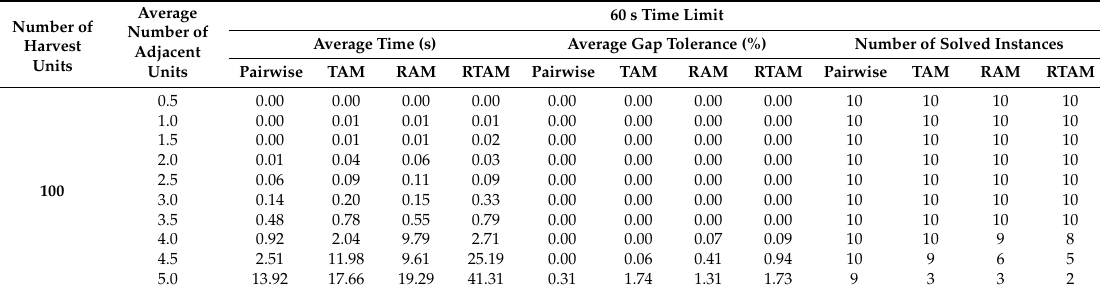
Table 1. Solving time, gap tolerance and number of solved instances for 60 s time limit and 100 harvest units.